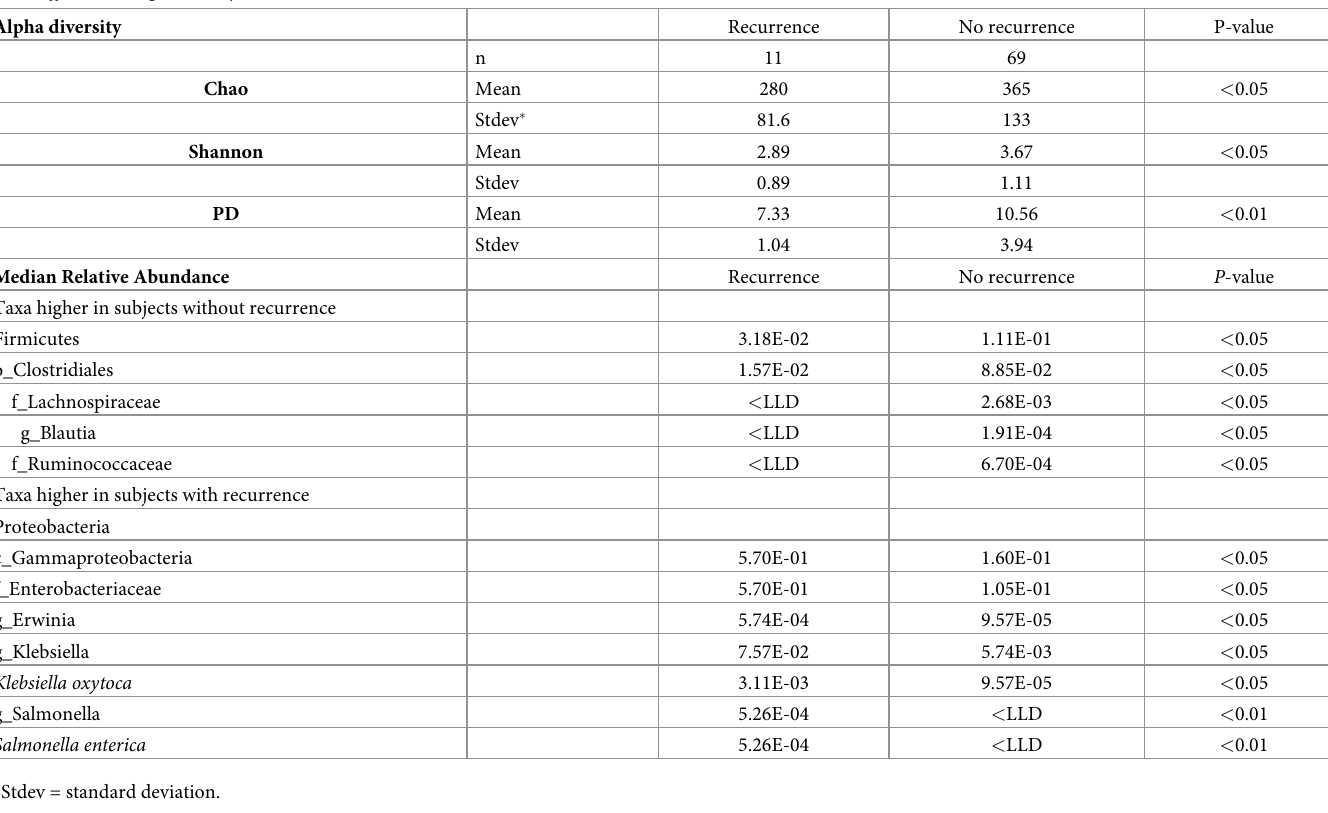
Table 4. Differences at end of treatment in alpha diversity and median relative abundance of taxa between subjects who had or did not have a confirmed recurrence of C . difficile during the